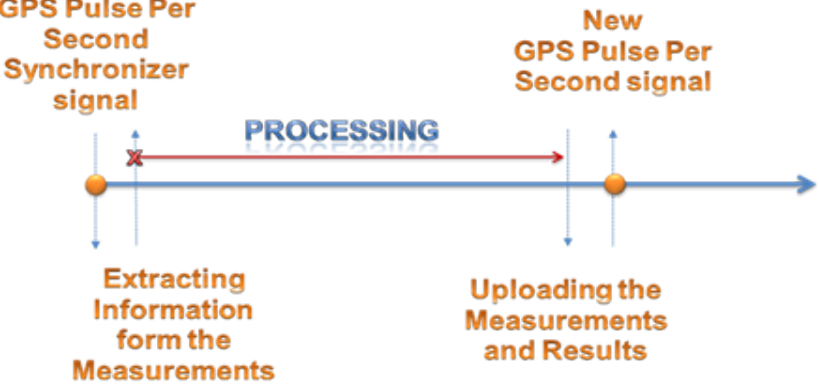
Figure 4. Measurements Synchronization, Information Extraction and Processing at 1 Hz